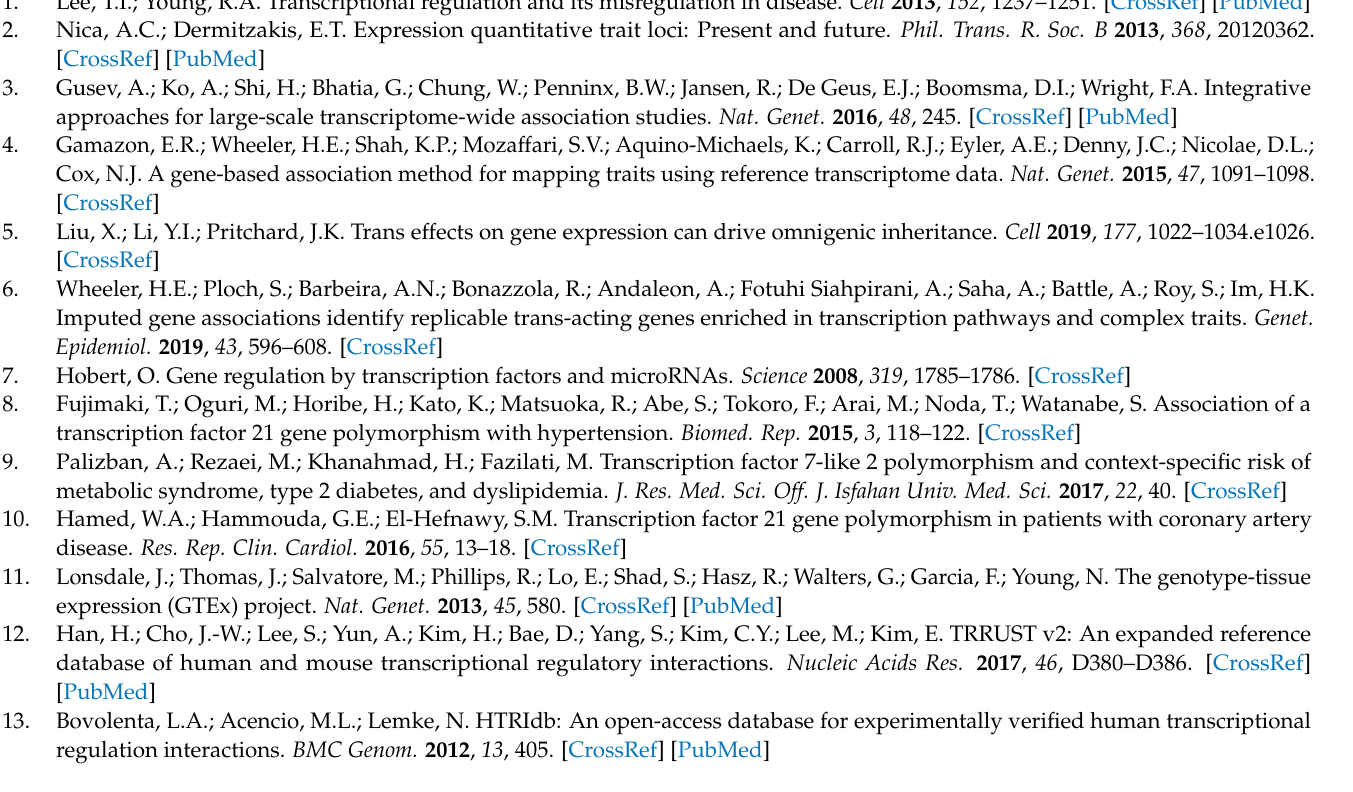
Table S2: Hit genes and their corresponding TFs with their LASSO model weights for the skeletal muscle and whole blood TF-expression and TF-binding models. Table S3: Model weights for TFs in TF-Expression model and nsSNPs for the TF-Binding model for all the hit